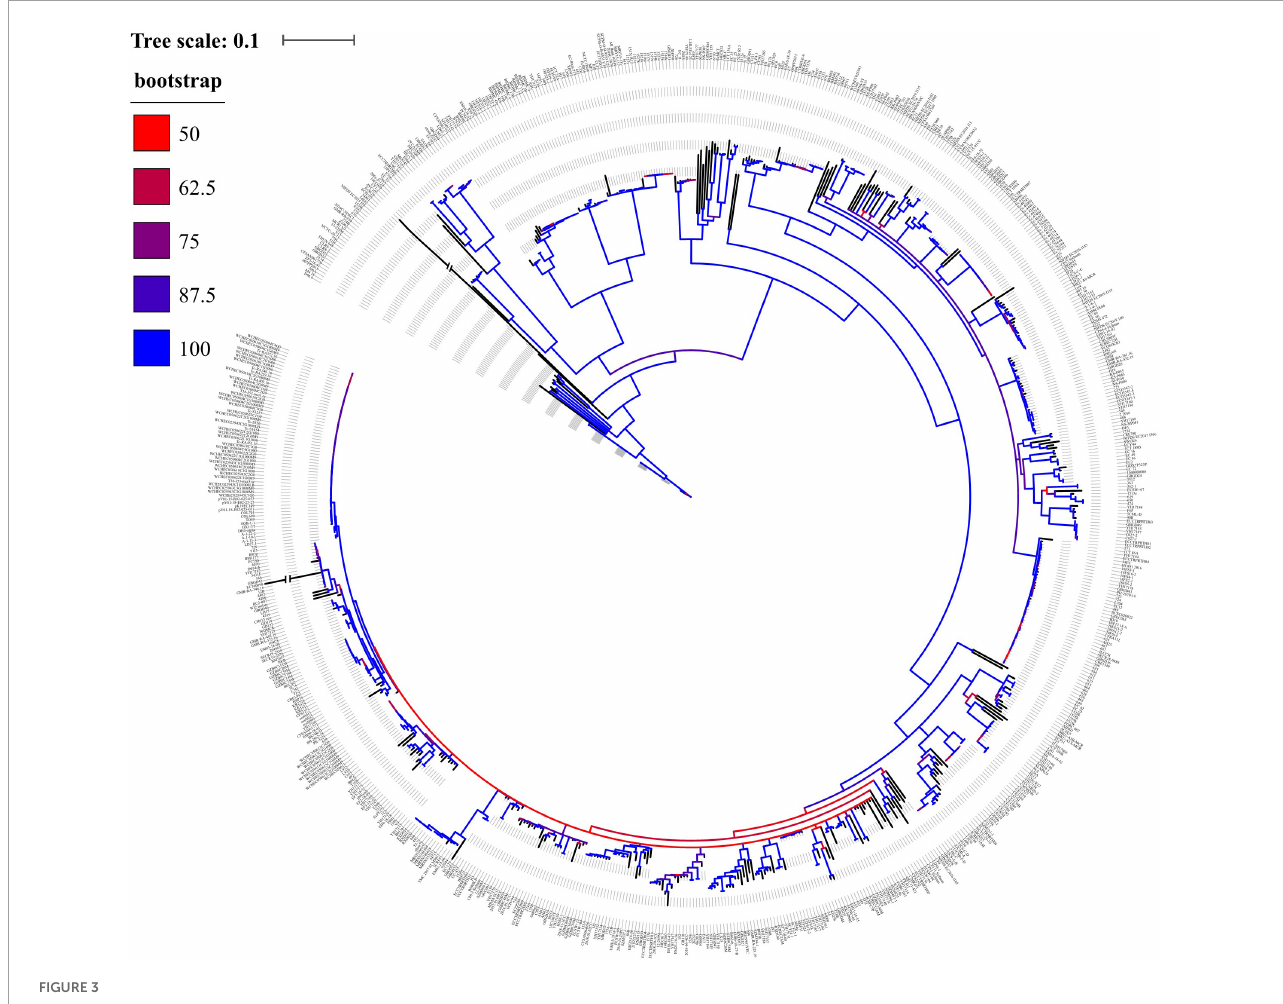
FIGURE3 Phylogenetic tree of 778 mcr-positive Escherichia coli